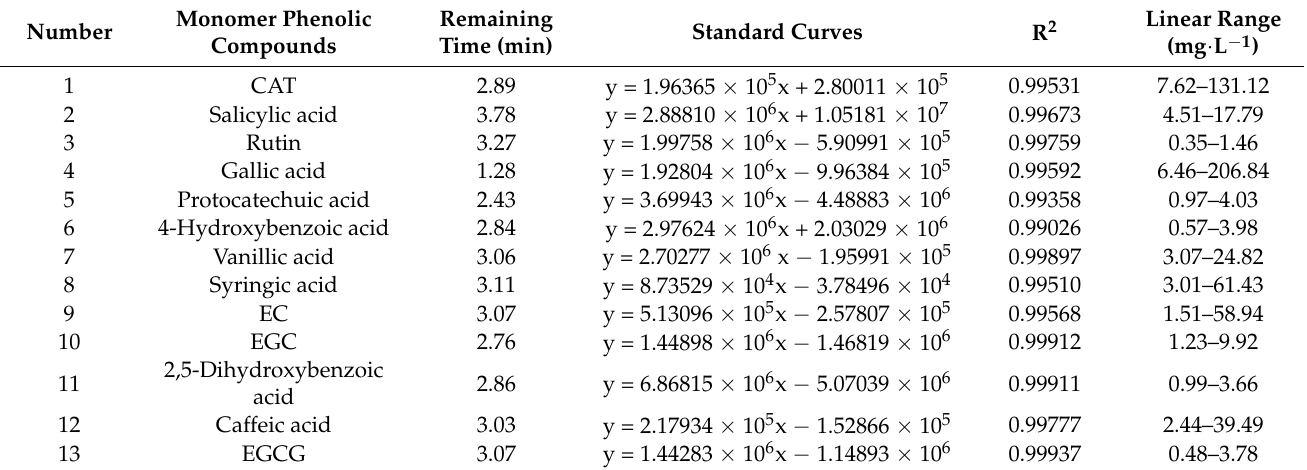
Table 2. Standard curves of nonanthocyanidin phenolic